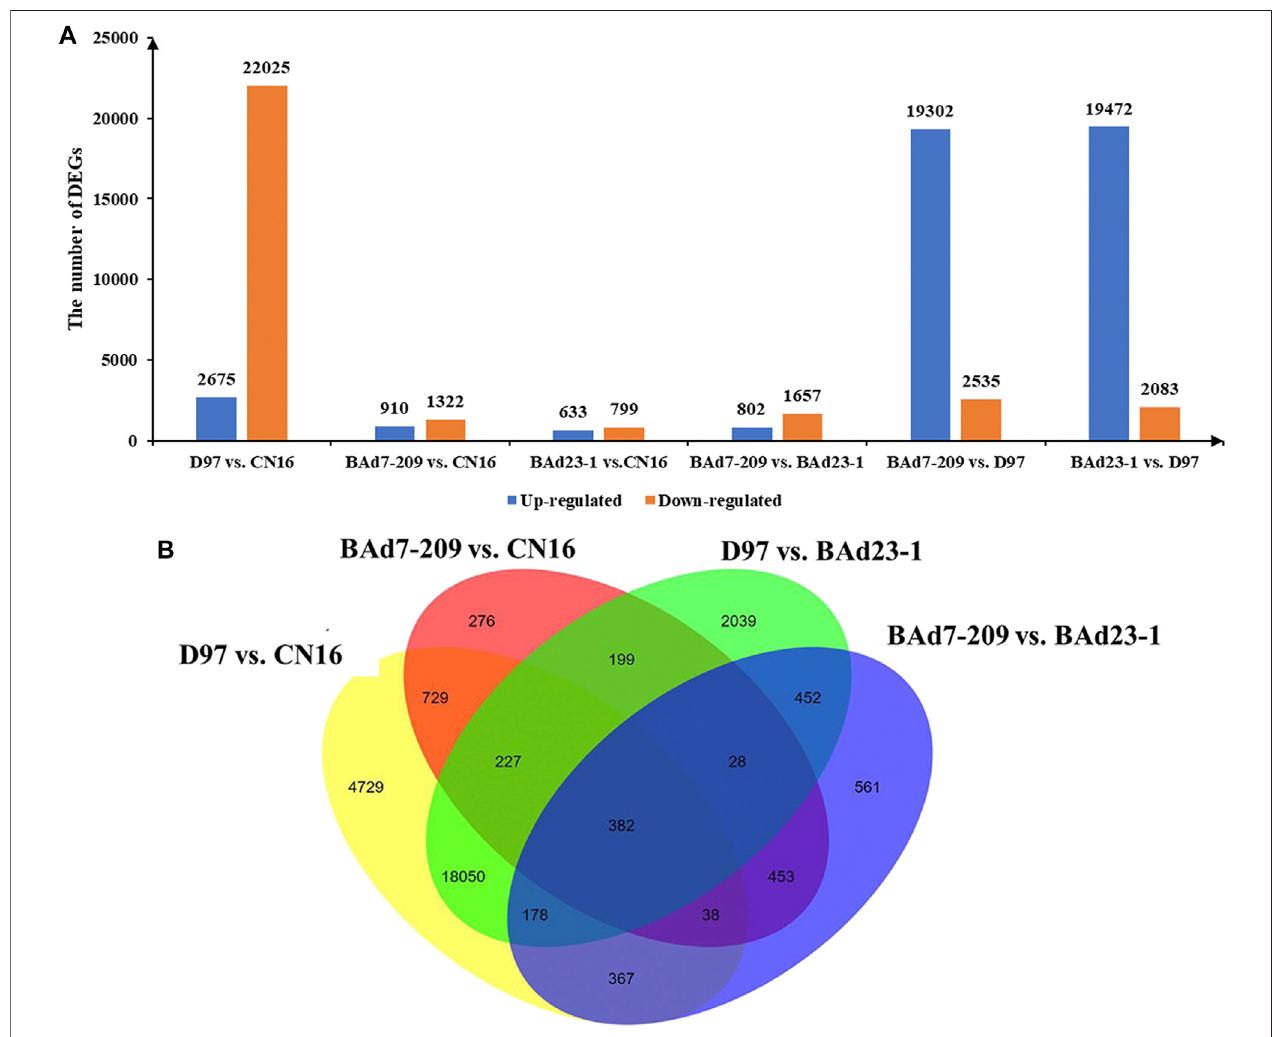
FIGURE3| ThehistogramsandVenndiagramsofDEGsindifferentcomparisons. (A) Up-anddownregulatedDEGsinBAd7-209andBAd23-1andtheirparents. (B) The Venn diagram of DEGs in the high-GPC (D97 + BAd7-209) vs. low-GPC (CN16 + BAd23-1) groups.